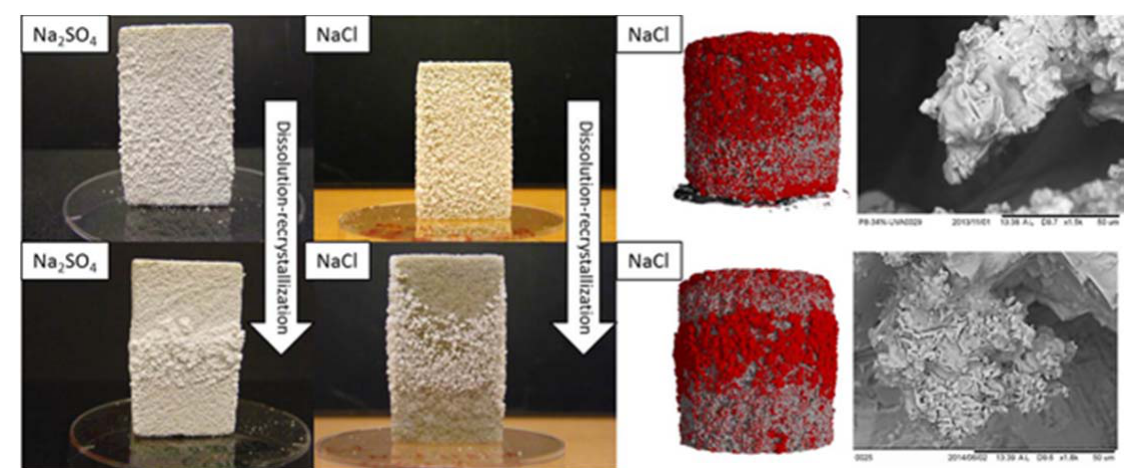
Figure 5. Salts contaminated stones (top images) are saturated with water and dried again (bottom images). Recrystallization in this way tends to extract the salt from the porous stone and favors more localised cauliflowers structures as efflorescence. X ‐ ray µ ‐ CT analysis of NaCl at the surface after dissolution recrystallization. The SEM images show the larger size of NaCl cauliflowers efflorescence after several cycles [94]. Reproduced with authorization from